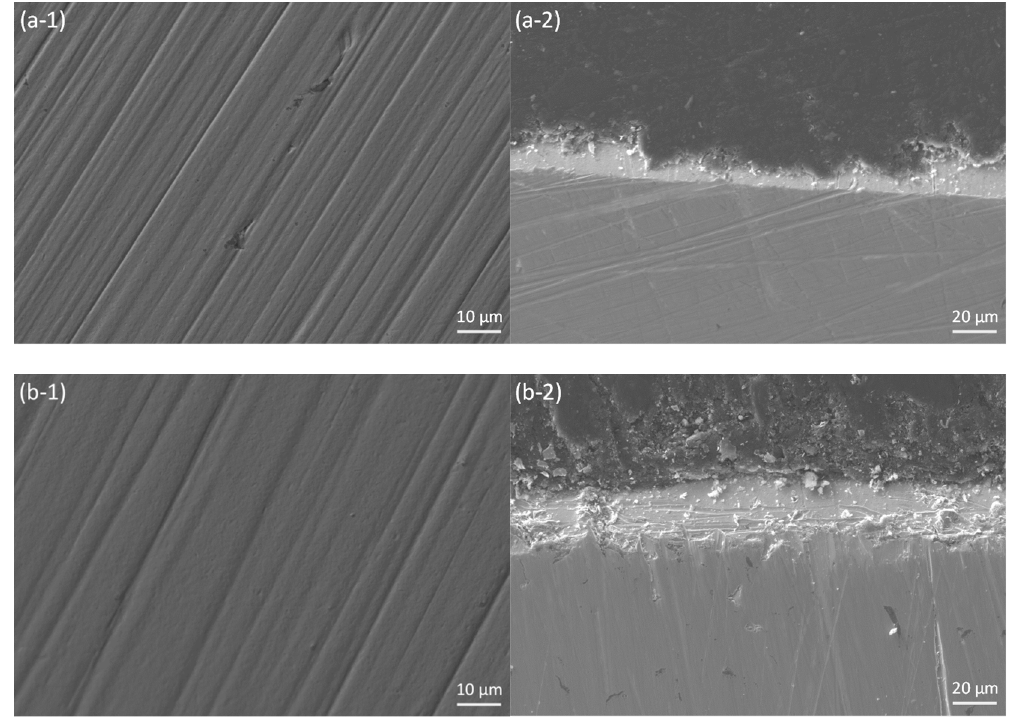
Figure 11. SEM morphologies for AISI 304L stainless steel after 44 h of erosion–corrosion ( a ) and erosion ( b ), process in a tailing slurry at 6000 rpm. Top section ( 1 ) and cross section ( 2 ).